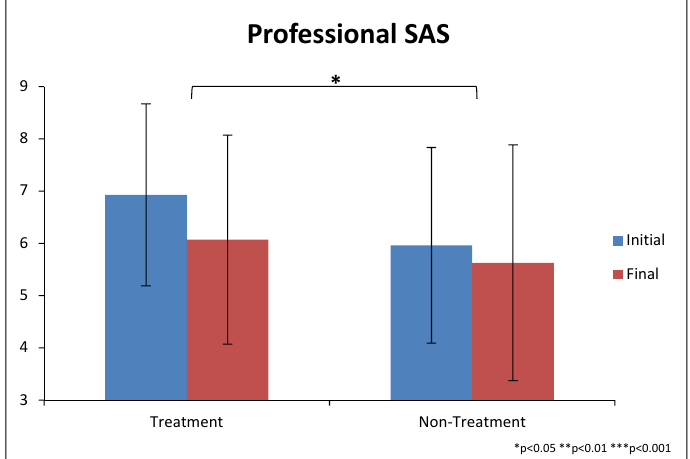
Figure 5. SAS scores (as rated by the professional evaluator) at beginning and end of the study. The scale goes from zero (no symptoms) to 10 (severe autism). Error bars represent standard deviations.